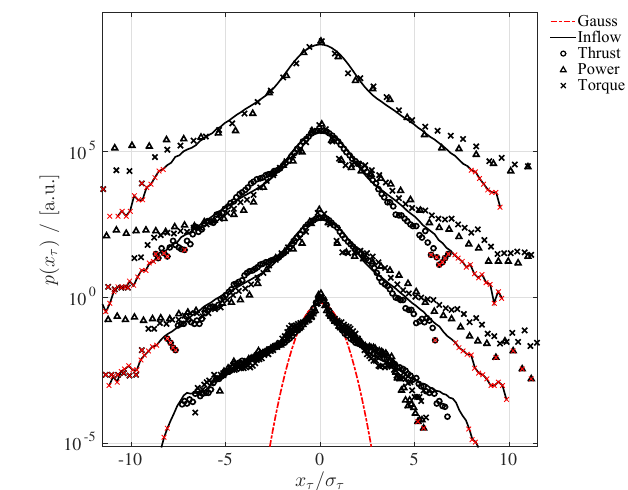
Figure 10. p ( x τ ) for the intermittent inflow condition (line, see Fig. 5a), thrust (circles), power (triangles) and torque (crosses). Scales as in Fig. 8 from top to bottom, τ = { 25 , 67 , 80 ms , 2 s } , shifted vertically for